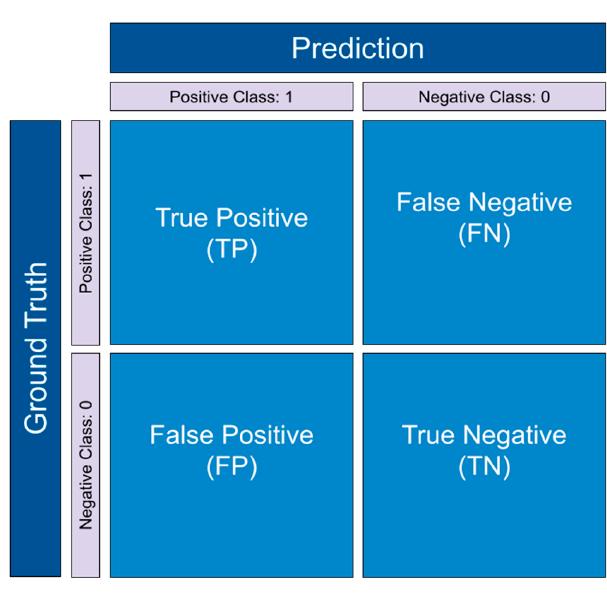
Figure 11. Confusion matrix.